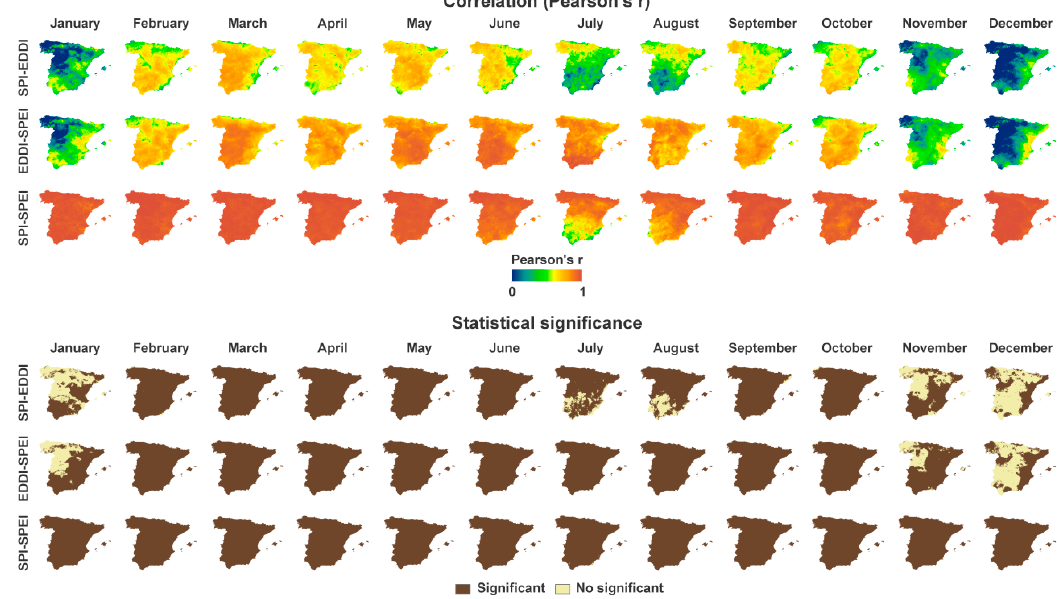
Figure 2. Spatial pattern of the correlation (Pearson’s r) and associated significance between monthly series of the SPI, EDDI, and SPEI over the period 1961–2018. The monthly series include the weekly data for the last week of each month in each